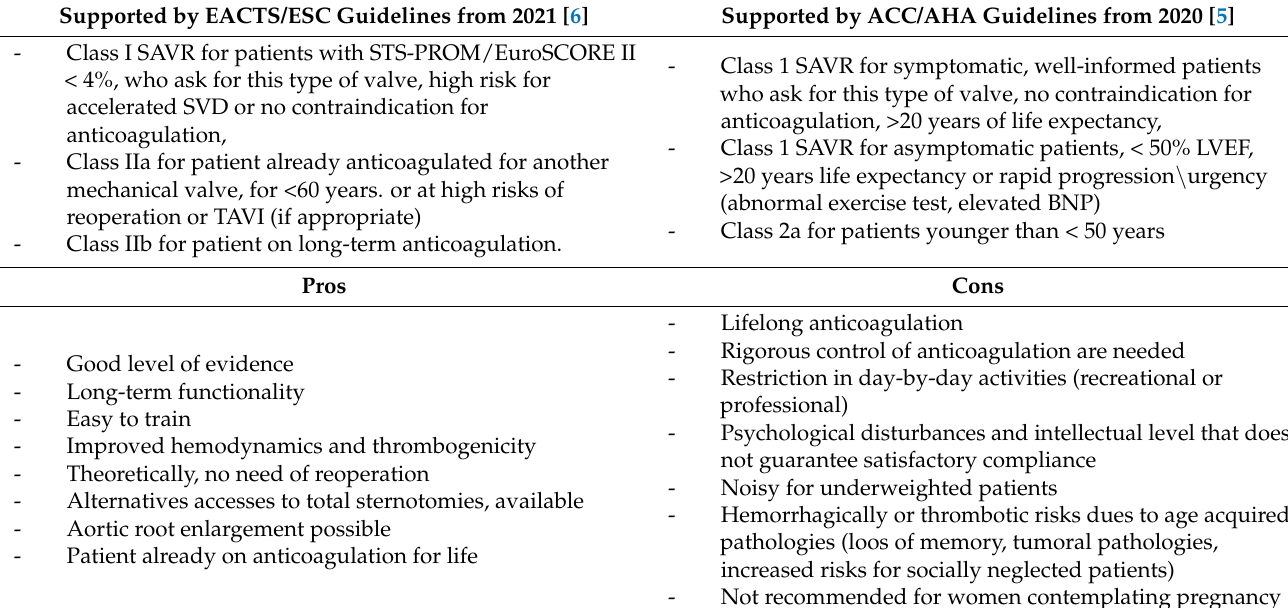
Table 2. Decision Making Algorithm. m-AVR for young patients.